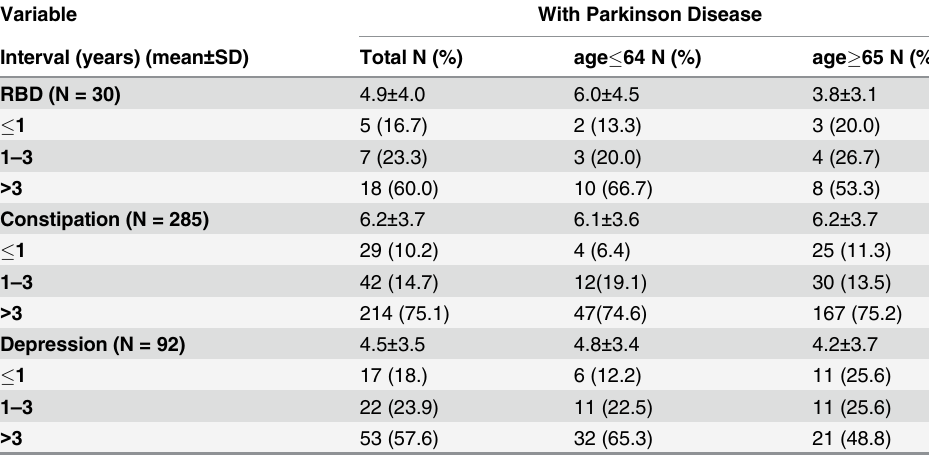
were 3.47, 2.19, and 2.48, respectively (Table 3, all p < 0.0001). This suggests that the three pre- motor symptoms were all significant and independent predictors of future PD risk. The average time interval between the diagnosis of RBD and PD was 4.9 years (SD 4.0) (Table 4). For patients with constipation or depression, the average interval between premotor symptoms and the PD diagnosis were 6.2 years (SD 3.7) and 4.5 years (SD 3.5), respectively (Table 4). For those with RBD, 60.0% were diagnosed with PD at least 3 years after their initial diagnoses of RBD (Table 4). Among those with constipation or depression, 75.1% and 57.6%, respectively, had their premotor symptoms at least 3 years earlier than the diagnosis of PD. In the middle-age onset group, subjects with RBD had a 7.20-fold risk for developing PD in the coming years (Table 5, p < 0.0001). However, in the old-age onset group, subjects with RBD carried a modest risk for PD (OR = 2.24, p = 0.02). Similarly, constipation was associated with a higher risk for PD in the middle-age onset group as compared to the old-age onset Table 4. Time interval between the premotor symptoms and the PD diagnosis.